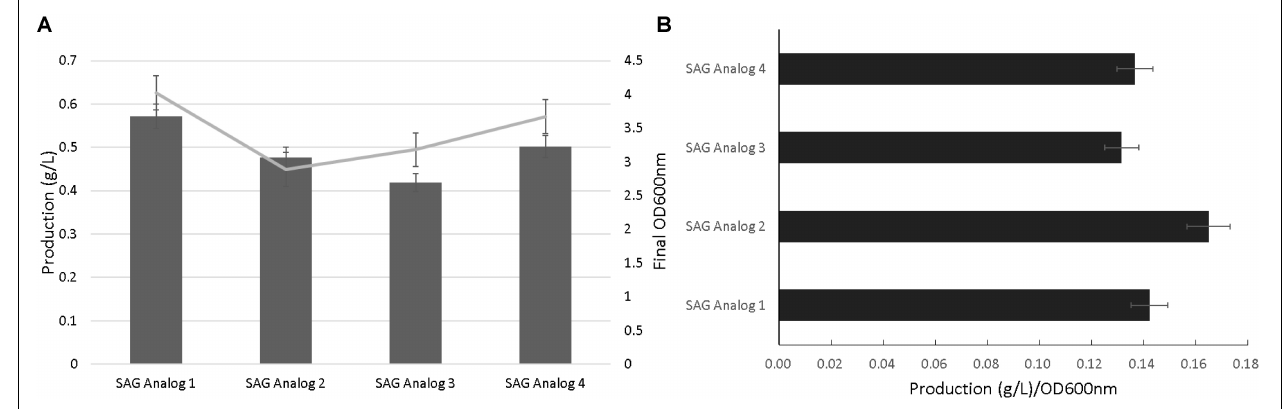
FIGURE 4 | Salicylate 2-O- β -D-glucoside analog production. Final OD 600 nm and production levels (A) and normalized production per cellular density (B)